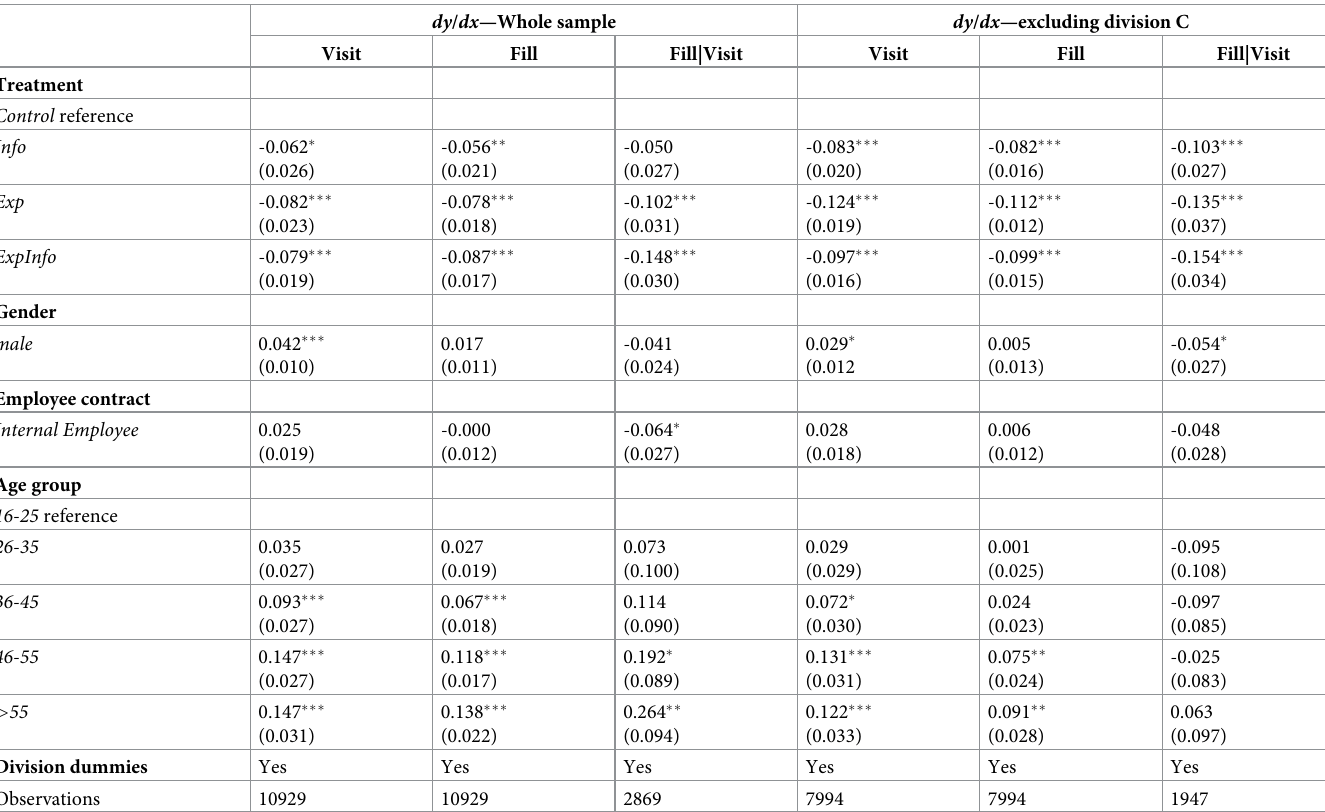
Table 4. Logistic regression analysis—Average marginal